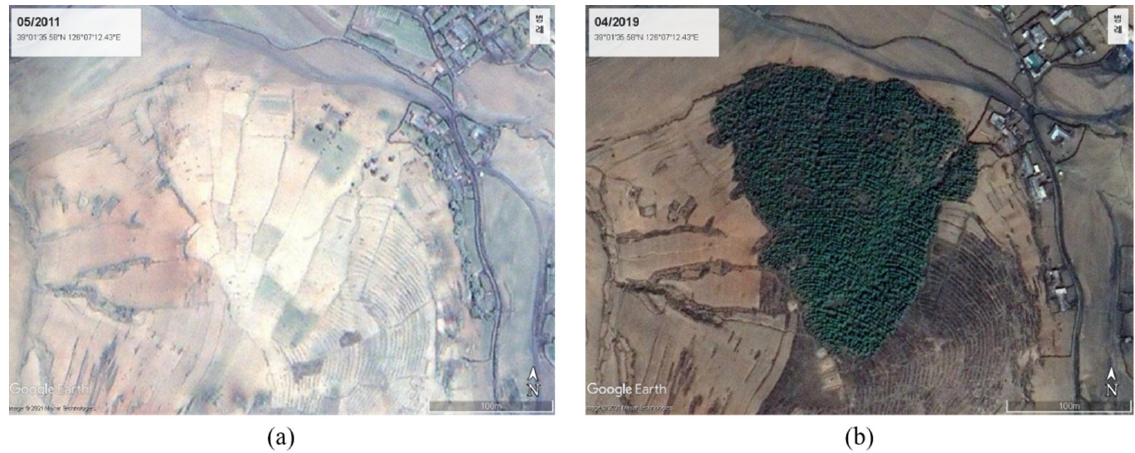
Figure 2. Afforestation site in North Korea (39 ◦ 01 (cid:48) 35.58”N, 126 ◦ 07 (cid:48) 12.43”E): ( a ) May 2011; and ( b ) April